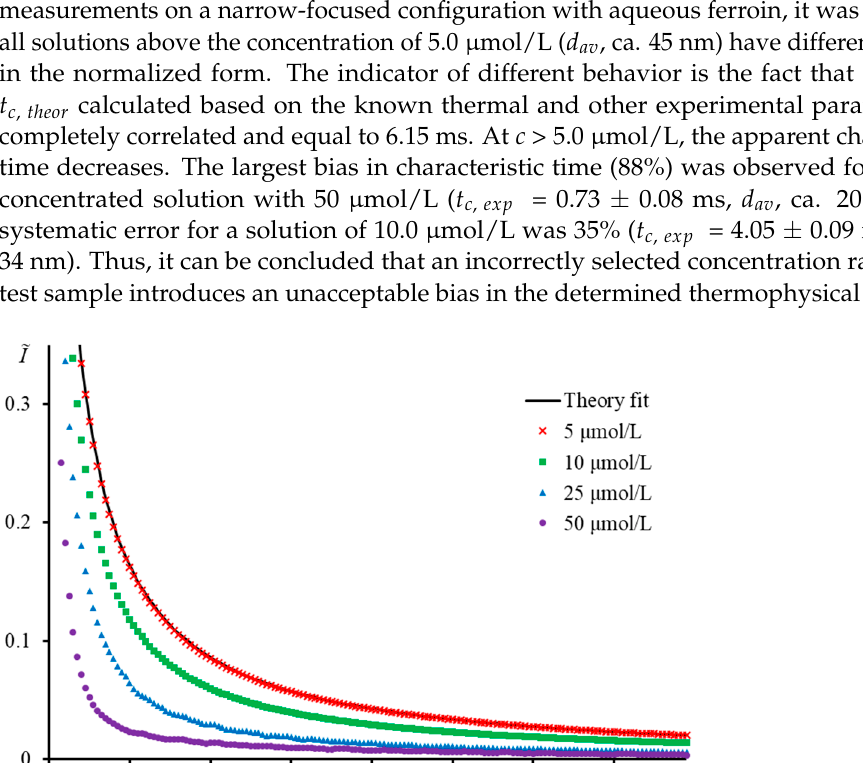
Figure 14. Transient curves in the normalized form of a solution of Sudan I in ethanol (2.5 µmol/L) at different excitation laser powers; middle-focused configuration ( 𝜔 (cid:3032)(cid:2868) = 42 µm, Figure 2, Table 3). Based on our results, the highest limit of concentration for organic solvents (in par- ticular, for ethanol) in TLS is more than an order of magnitude lower than for water: 5.0